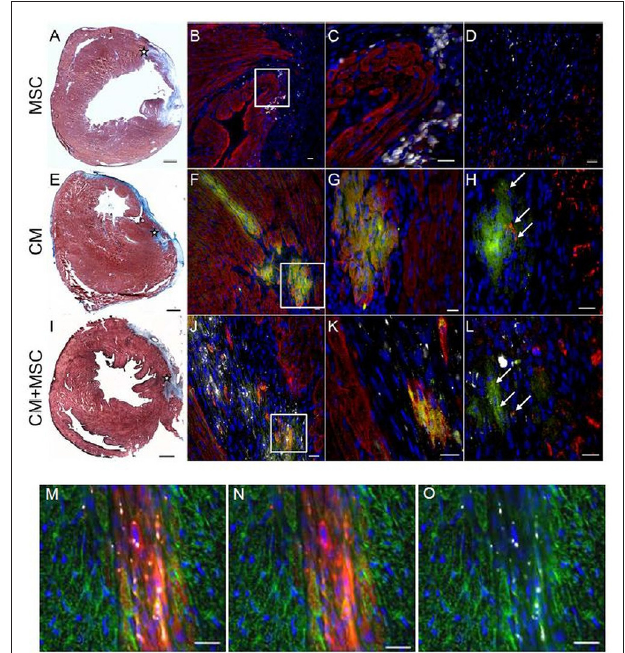
FIGURE 4 | Immunohistochemical detection of transplanted cells in host myocardium. Representative photomicrographs from three experimental groups 4 weeks after intramyocardial injections of either MSC (A–D) , iPS-CM (E–H) , or iPS-CM + MSC (I–L) . (A,E,I) Masson’s Trichrome stainings of transverse sections of hearts 4 weeks after operations with fibrotic scar tissue stained blue. The injection site in the peri-infarct region is marked with an asterisk. Scale bars: 500 µ m. (B,F,J) Immunohistological stainings of sections containing transplanted cells 4 weeks after operations. eGFP (green), α -actinin (red), microspheres (white), nuclei (blue). Scale bars: 20 µ m. (C,G,K) Magnified view of areas in white boxes in images at left. Scale bars: 20 µ m. (D,H,L) Immunohistological stainings of the same area in neighboring sections of sections shown in images at left. eGFP (green), connexin 43 (red), microspheres (white), nuclei (blue). Scale bars: 20 µ m. (M,N,O) Immunohistological stainings of sections from the MSC group with grafted MSC showing co-localization of internalized microspheres (white) with membrane stain Vybrant DiI-CM (red). α -actinin (green), nuclei (blue). Scale bars: 20 µ m. eGFP, enhanced green fluorescent protein; CM, cardiomyocytes; MSC, mesenchymal stromal cells. compared to the placebo group (1,704.4 ± 173.0/mm 2